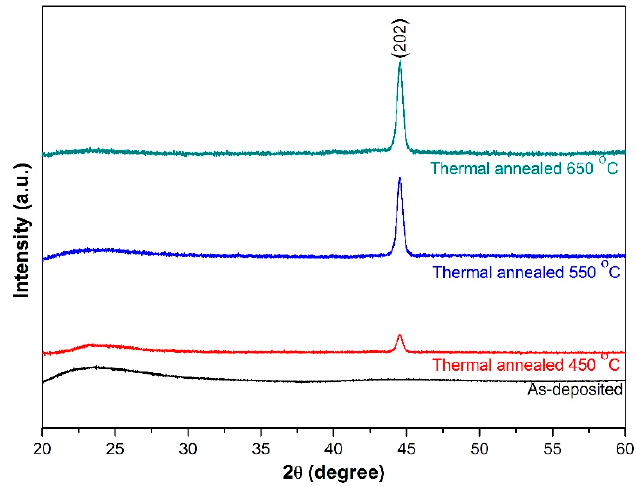
Figure 6. X-ray diffraction patterns of PECVD silicon thin films: as-deposited, furnace annealed at 450 °C, furnace annealed at 550 °C, and furnace annealed at 650 °C. Preferred crystallographic orientation was (202). The vertical axis was plotted with y -offset for comparison.